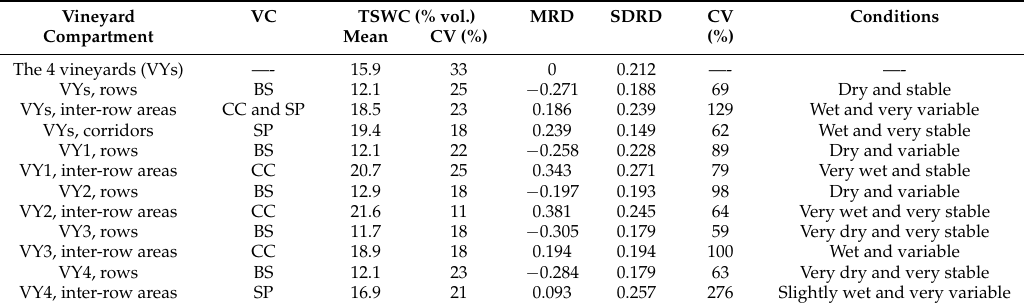
Table 4. Topsoil water content (TSWC) in the different vineyards and compartments over the test period. The mean relative difference (MRD), standard deviation of the MRD (SDRD) and the coefficients of variation (CV) are included. TSWC (%